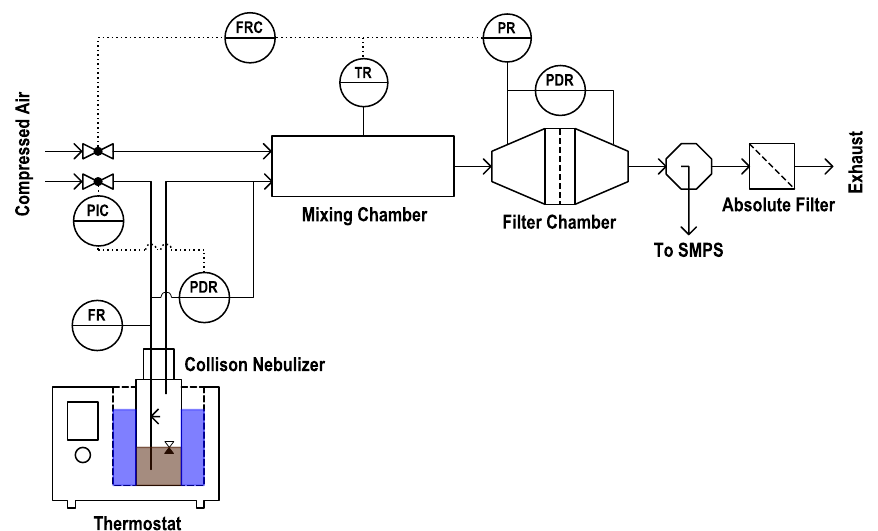
Figure 2. Experimental set-up for the loading of self-produced thin filter material with oil mist. The oil mist was generated by a Collison nebulizer placed in a thermostat at a constant temperature, mixed with dry compressed air and let into the filtration chamber.